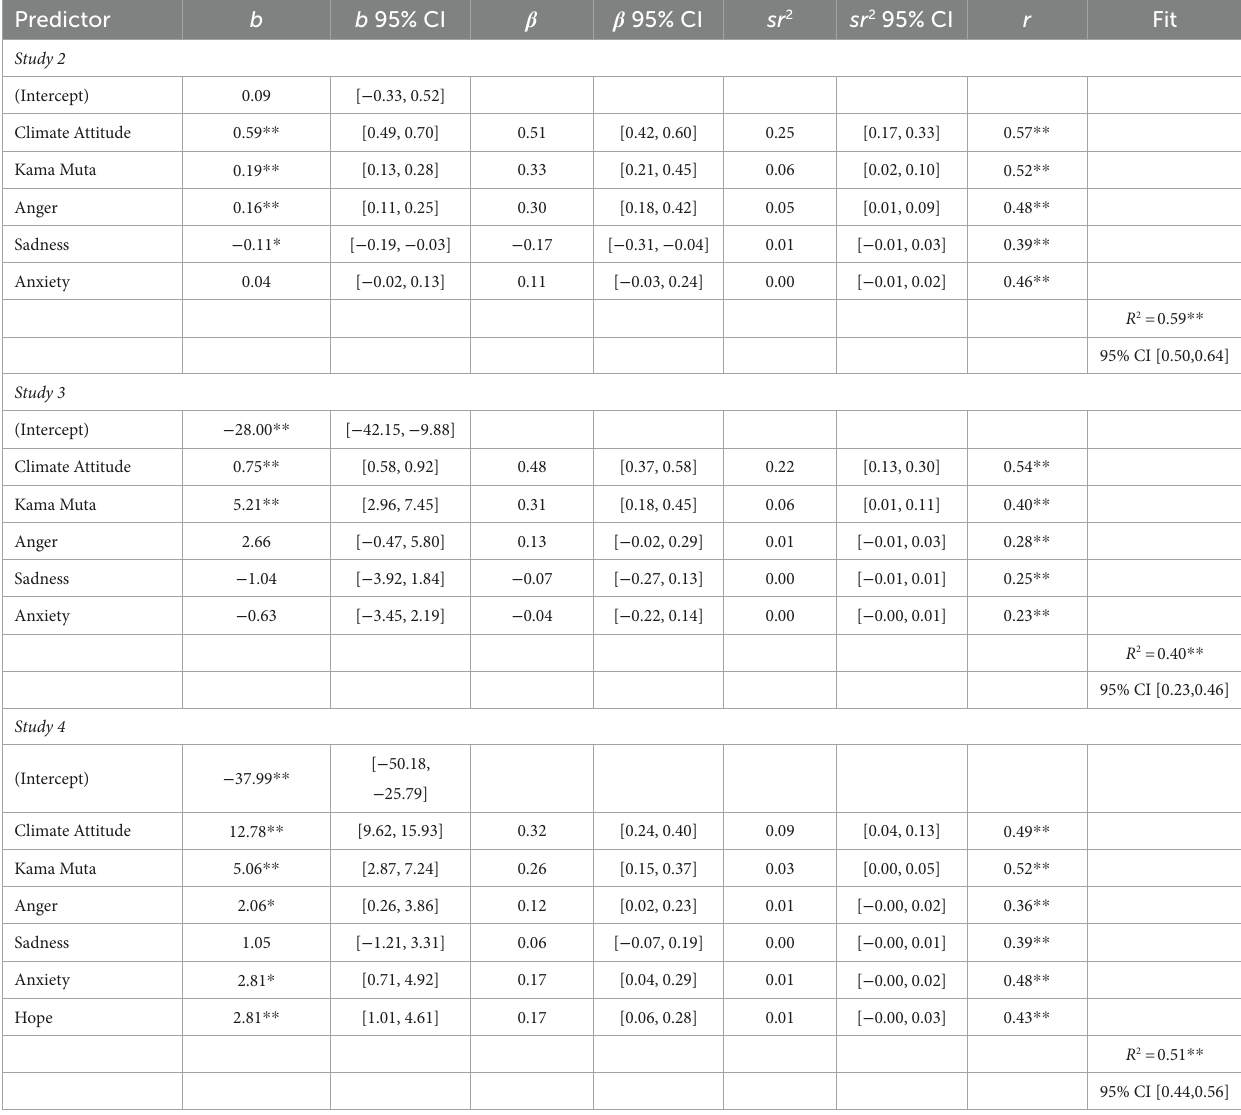
TABLE 3 Regression results using intentions as the criterion in Studies 2–4.